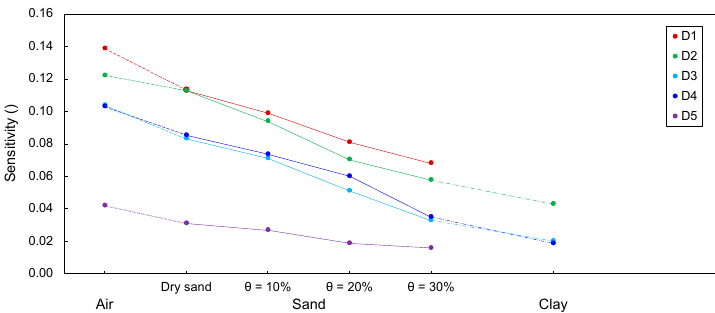
Figure 14. Variation in sensitivity according to different materials filling defects.